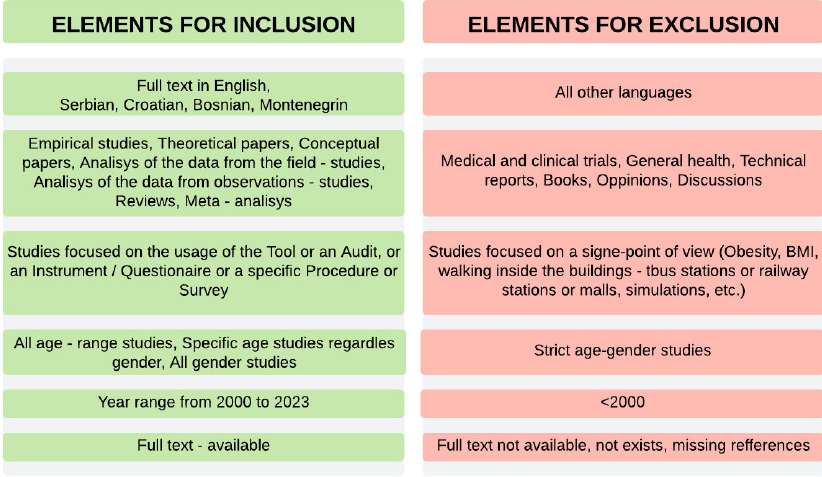
Figure 4. Elements for the inclusion or exclusion of the available studies.